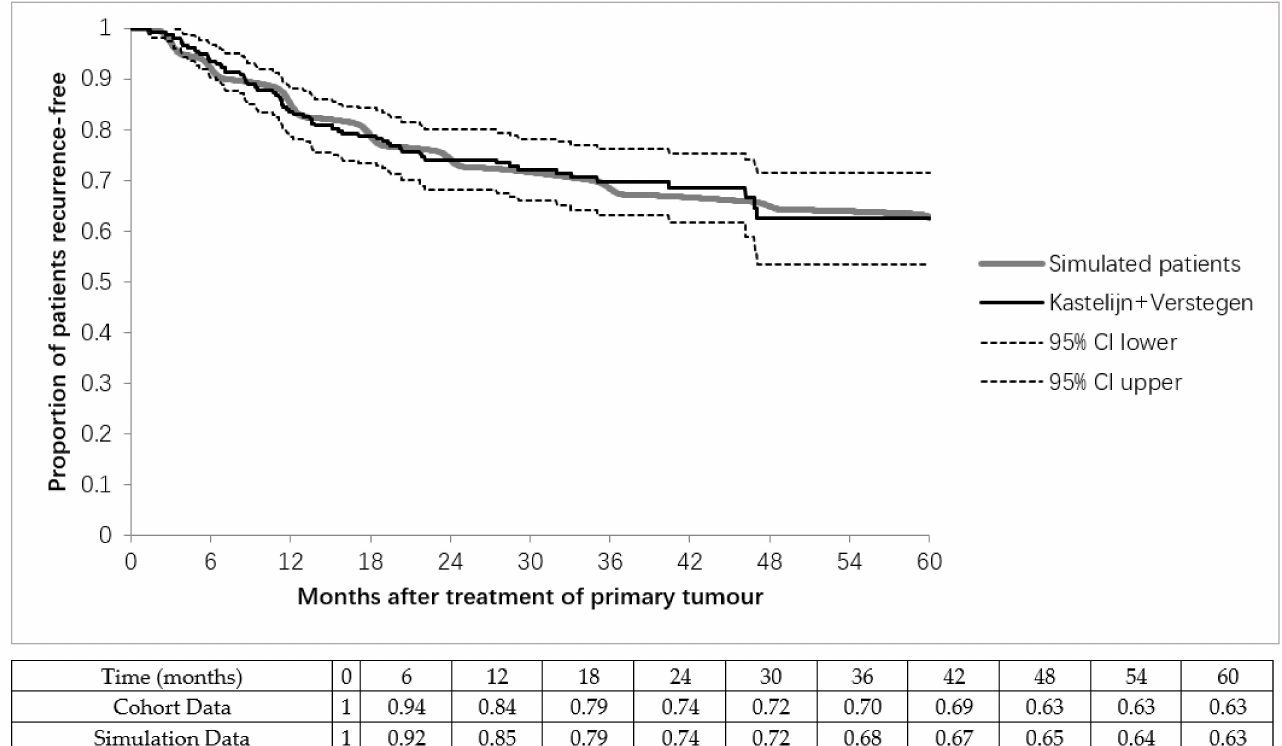
Figure 3. Detection of recurrences. Recurrence-free survival after curative treatment of the primary tumour of the simulated patients is calibrated to match two Dutch cohorts [24,25]. Recurrences are detected with a surveillance scan schedule and unplanned additional scans using a symptom hazard model. A total of 62.5% of the Dutch cohorts remained recurrence-free. Patients without recurrences were not simulated but were added after the simulation for the purpose of showing the differences between the simulated patients and the Dutch cohorts in this figure. Number of detected recurrences per month. Asymptomatic recurrences were only detected during surveillance scans. These scans were planned according to a fixed schedule, with a small variation in scan date N ( µ = FU schedule, σ = 15.5). Symptomatic recurrences were detected throughout the year, and detection times were determined with the hazard model (Function